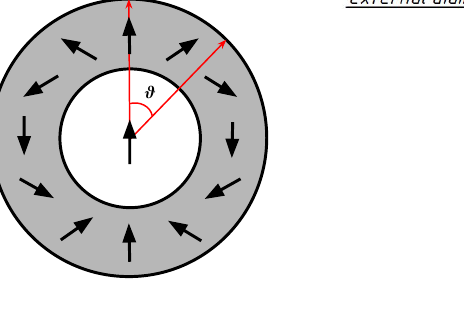
Figure 13. ( Left ) Magnetization directions in the Halbach configuration of a dipole field. ( Right ) Two rings, 16 segment Halbach configuration of the PVLAS-FE magnets with the external cylindri- cal enclosure.